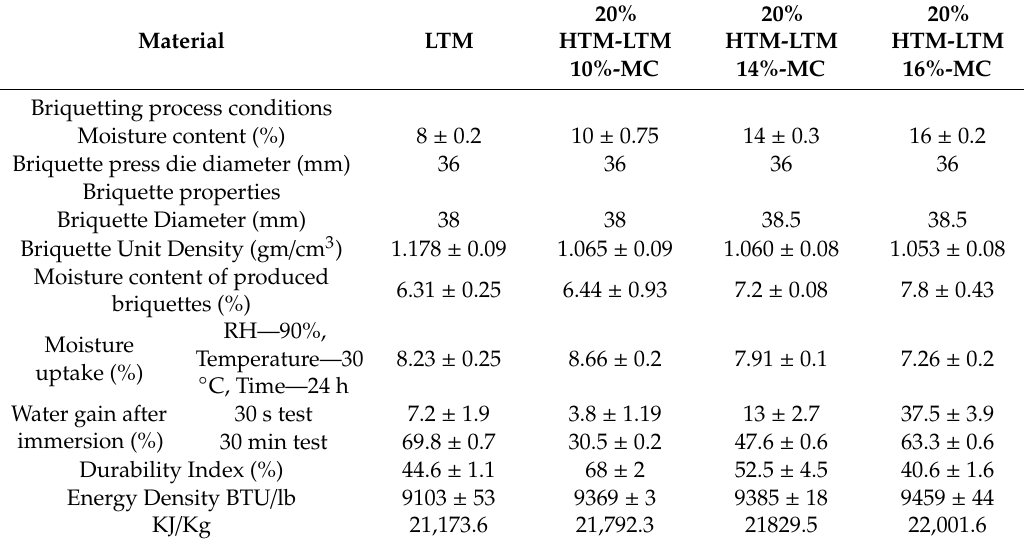
Figure 6. FTIR spectrums of the treated biomass used in this work. Table 3. Characterization results (average) for briquettes produced using 36-mm-diameter die.